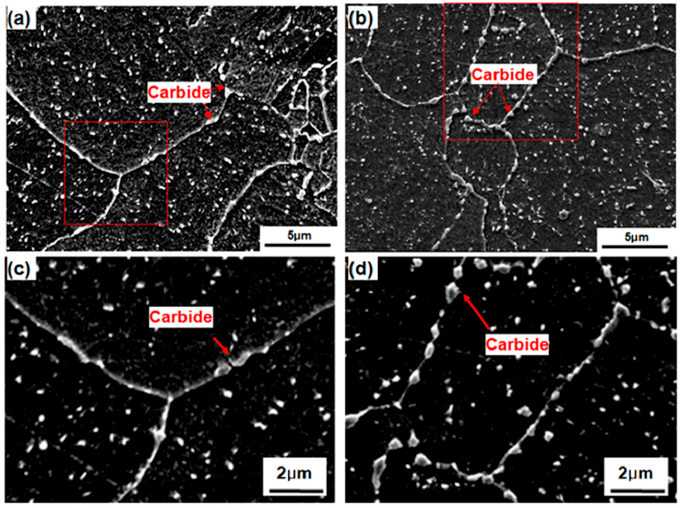
Figure 11. SEM image of the base metal ( a ) 386J and enlarged red square ( c ); ( b ) 28J and enlarged red square ( d ).